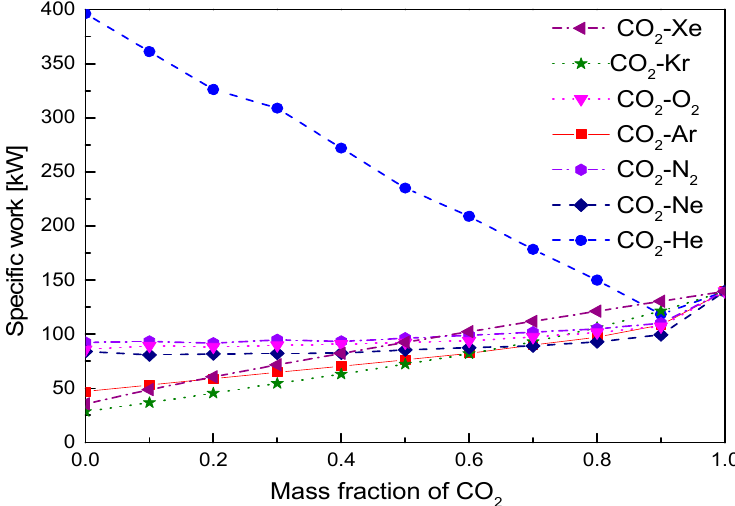
Figure 7. Specific work of mixtures at different mass fractions of CO 2 .